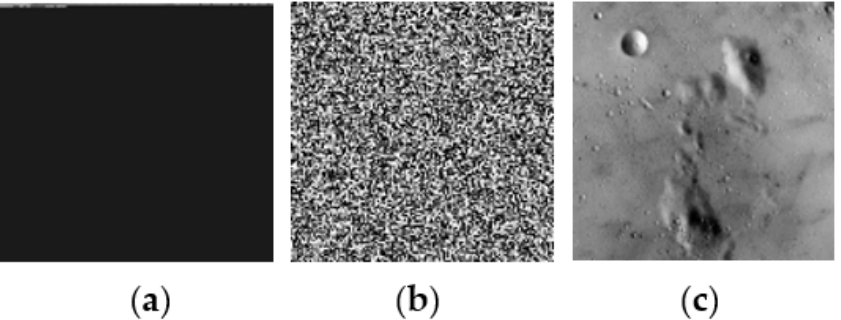
Figure 2. Various types of image models: ( a ) simple; ( b ) complicated; ( c ) very complicated. Considering a 2-D space, which has been partitioned into n-pixels, labeled by the integers 1, 2, …n (rectangular space); x ij or x i denote the color for pixel (i) or (i,j); p(..|..) defined as the conditional probability distribution (Figure 3) ([3–6]).